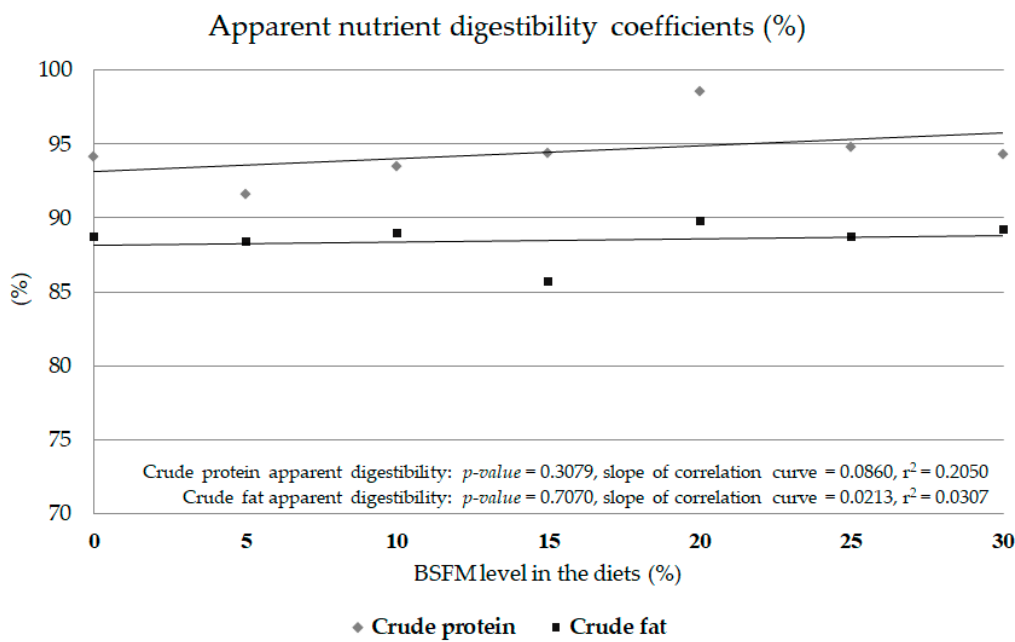
Figure 1. Apparent nutrient digestibility coefficients (%) in Siberian sturgeon fed experimental diets containing black soldier fly full-fat meal (Experiment 3). Points on the horizontal axis represent the level of BSFL inclusion and treatments. 0: CON, control feed; 5: H5, experimental feed with 5% BSFL; 10: H10, experimental feed with 10% BSFL; 15: H15, experimental feed with 15% BSFL; 20: H20, experimental feed with 20% BSFL; 25: H25, experimental feed with 25% BSFL; 30: H30, experimental feed with 30% BSFL.